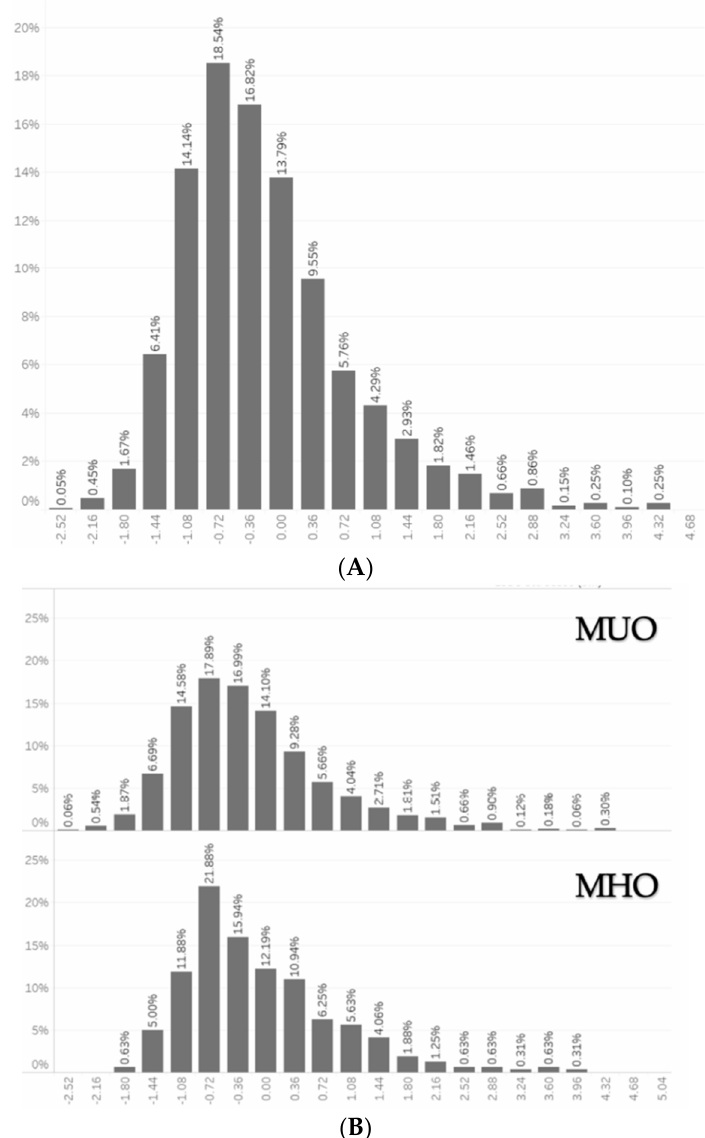
Figure 1. ( A ) Distribution of IGF-1 zSDS in the overall study population. ( B ). Distribution of IGF-1 zSDS in the MUO and MHO subgroups. Abbreviations: IGF-1 zSDS, insulin-like growth factor 1 z standard deviation score; MUO, metabolically unhealthy obese group; MHO, metabolically healthy obese group. Variables are expressed as percentile of total population.